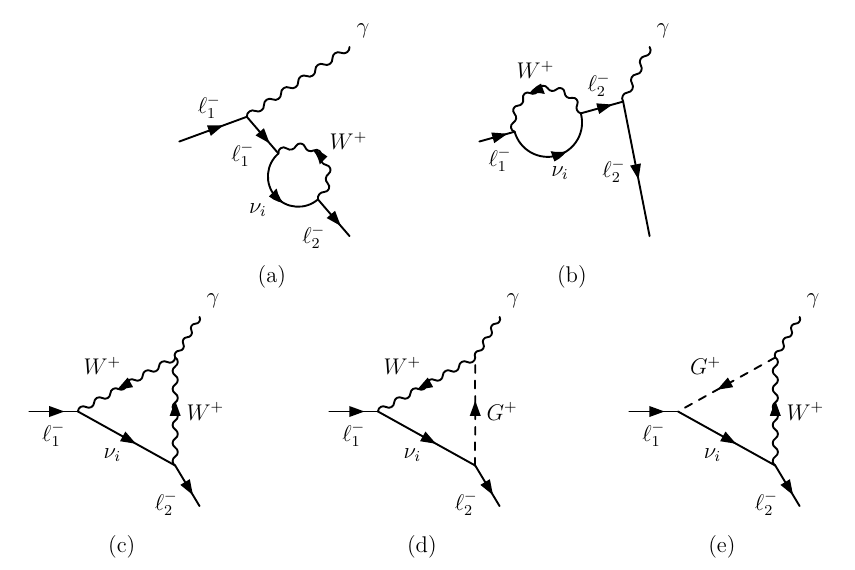
Figure 14 . The five diagrams for ‘ 1 − → ‘ 2 − γ with a loop containing W ±